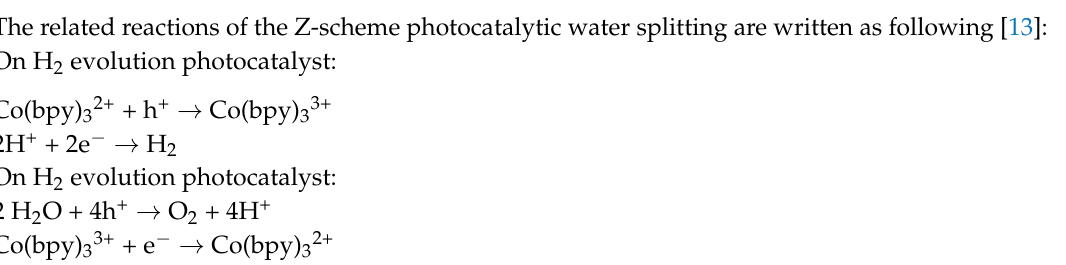
Figure 9. Time course of H 2 evolution and O 2 evolution for the Z-scheme photocatalysis water splitting on 1 wt % Ru/Rh:SrTiO 3 –BiVO 4 where ( a ) Ru/SS-STO2Rh ( b ) Ru/HT-STO2Rh ( c ) Ru/MW-STO2Rh-A ( d ) Ru/MW-STO2Rh-T was used as H 2 evolution catalyst.